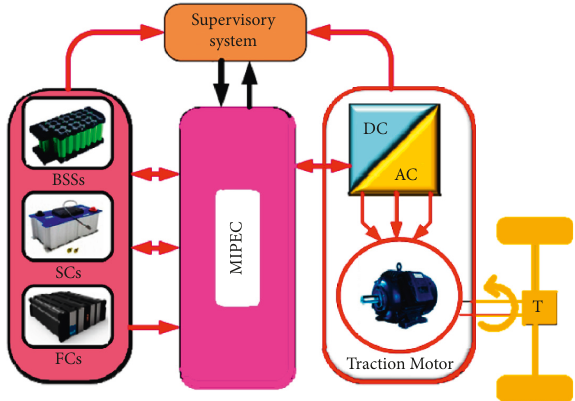
Figure 19: PI-based bidirectional